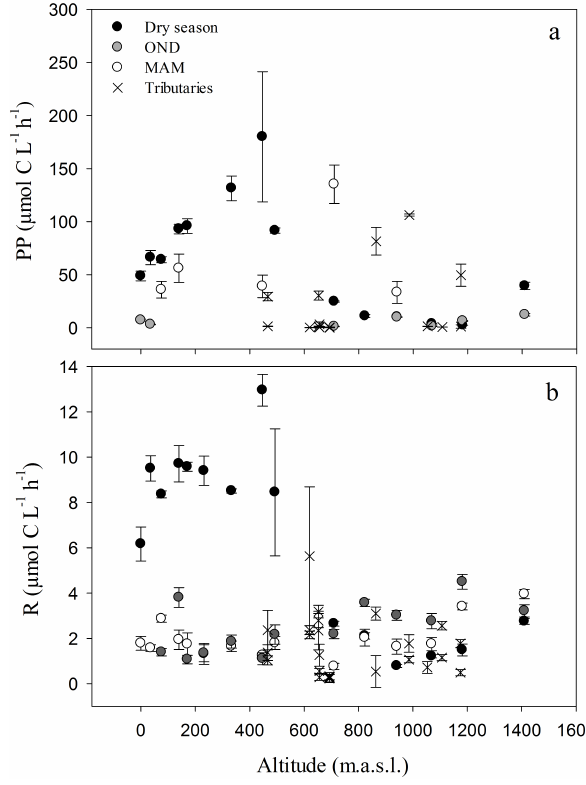
Fig. 8. Altitudinal gradient during dry season (August–September 2011), short rain season (October–December, OND, November 2011) and long rain season (March–May, MAM, April 2012) and tributaries (x, all seasons) of surface water (a) pelagic primary pro- duction (including error bars), and (b) community respiration rates (including error